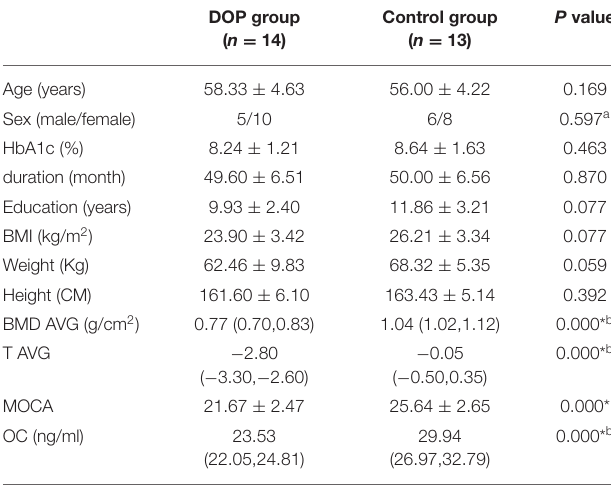
TABLE 1 | Demographic, clinical, and cognitive